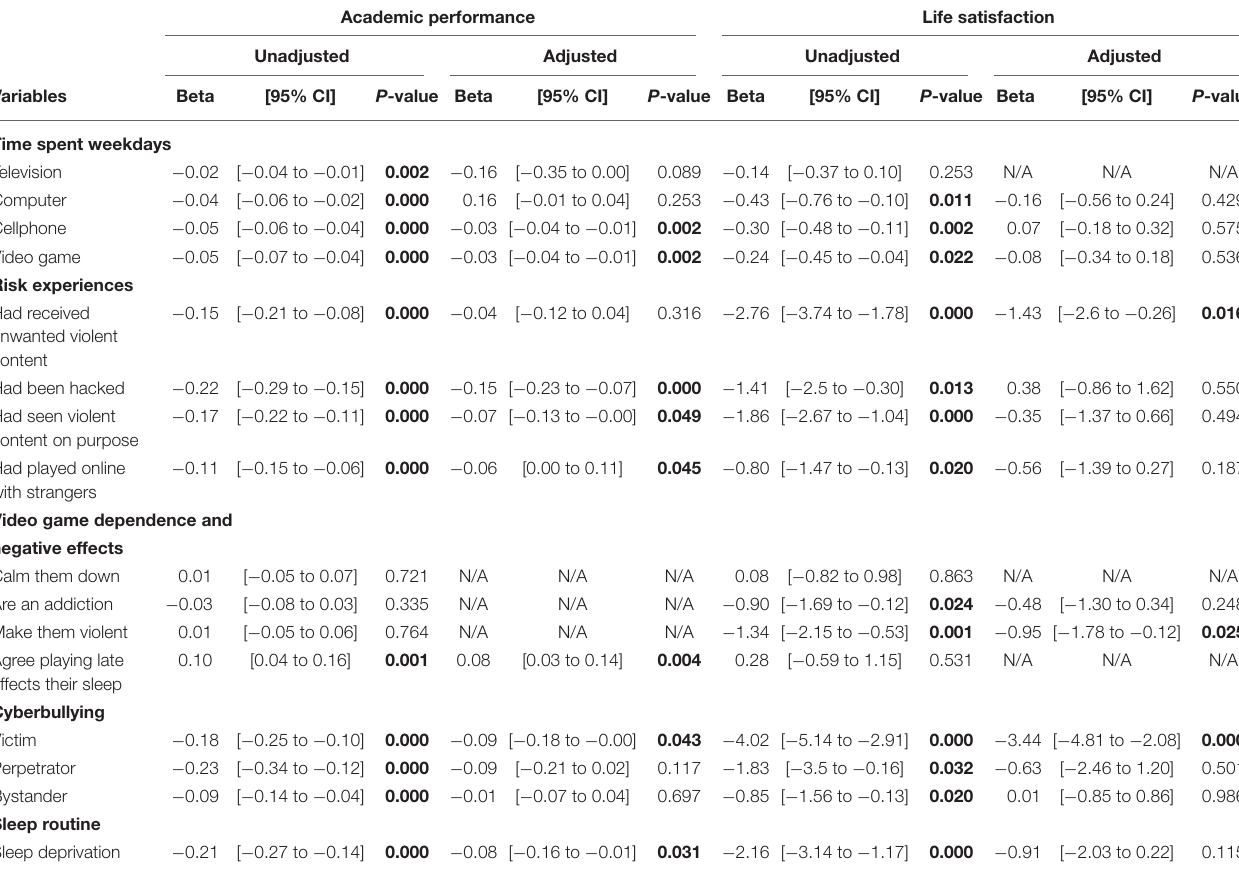
TABLE 8 | Associations between time spent using technological devices during weekdays and academic performance and life